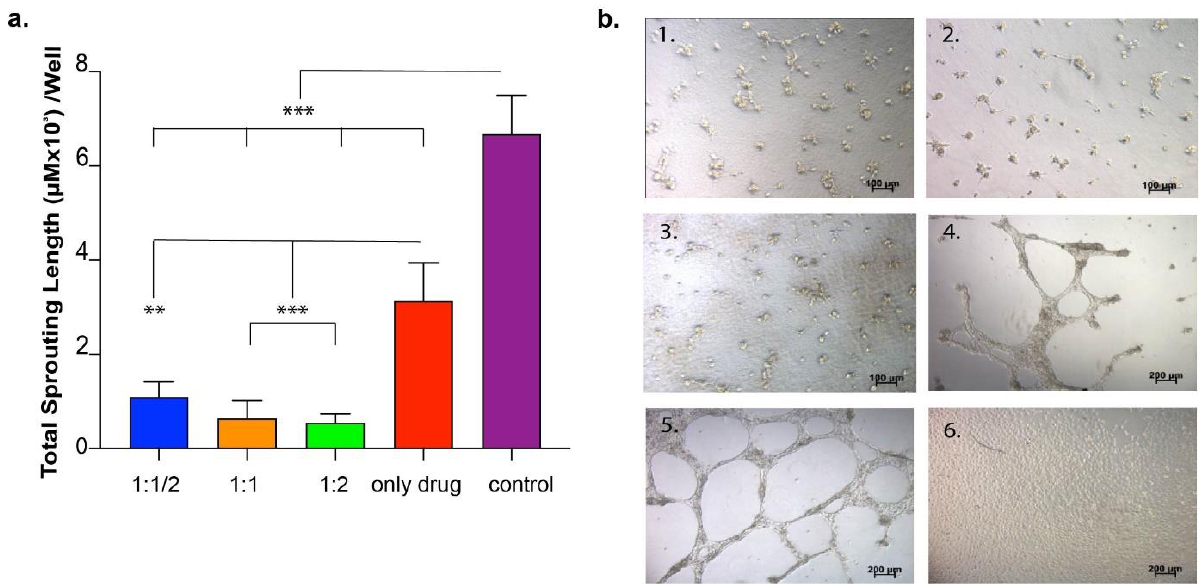
Figure 5. In vitro angiogenesis model used to evaluate released drug functionality. ( a ). The number of total sprouting areas formed by HUVECs cultured on Matrigel in the presence of VEGF. Cells cultured in culture media with anti-VEGF delivery systems ([ranibizumab]:[PA]; 1:1/2, 1:1, 1:2 experimental groups), drug only and on TCP (no drug, VEGF, peptide molecules and Matrigel); ( b ) Light microscope images of HUVECs cultured in (1) delivery system 1:1/2, (2) delivery system 1:1, (3) delivery system 1:2, (4) drug only, (5) w/o drug and delivery system, (6) TCP. Values represent mean ± SEM, n = 3 (*** p < 0.0001, ** p < 0.01).